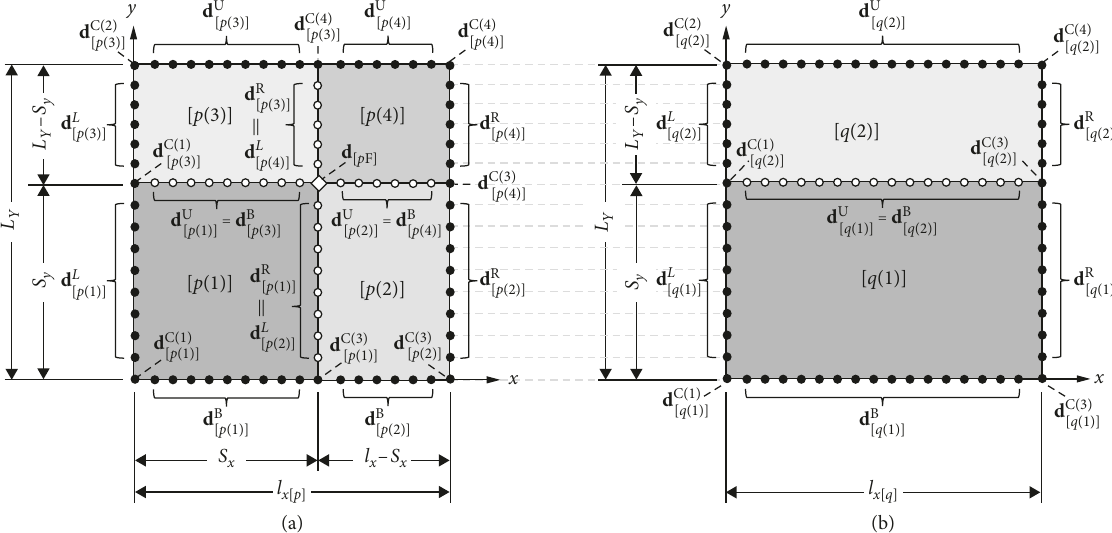
Figure 8: (a) Four-element model for the span subjected to a stationary point force F from the stationary point force. the interim nodes without external loadings. (a) When q (cid:31) ○